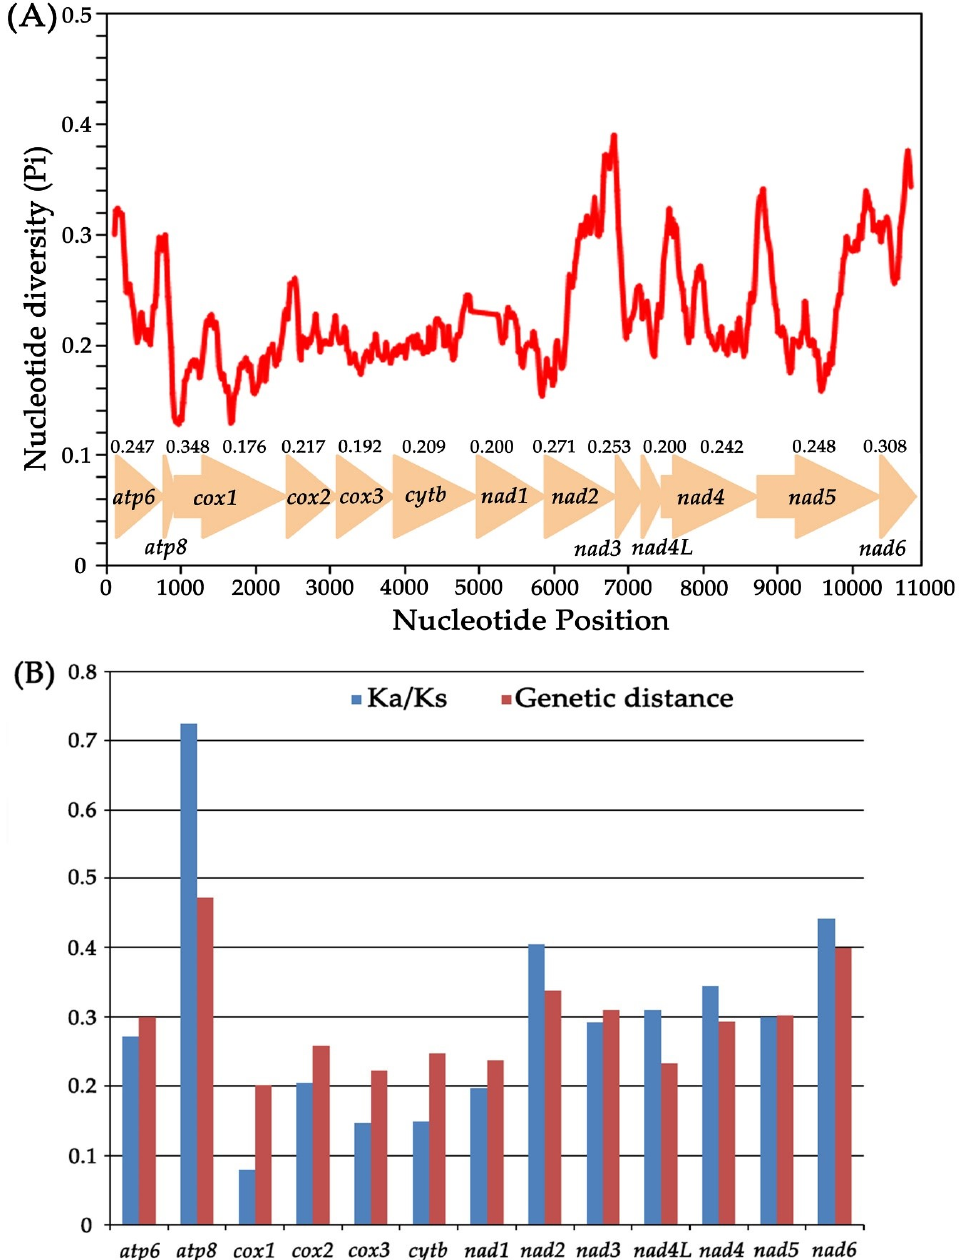
Figure 6. ( A ) Sliding window analysis of 13 aligned PCGs among five Drabescini mitogenomes. The red curve shows the value of nucleotide diversity (Pi). ( B ) Ratio of non-synonymous (Ka) to synonymous (Ks) substitution rates and genetic distance (on average) of 13 PCGs among five Drabescini mitogenomes.